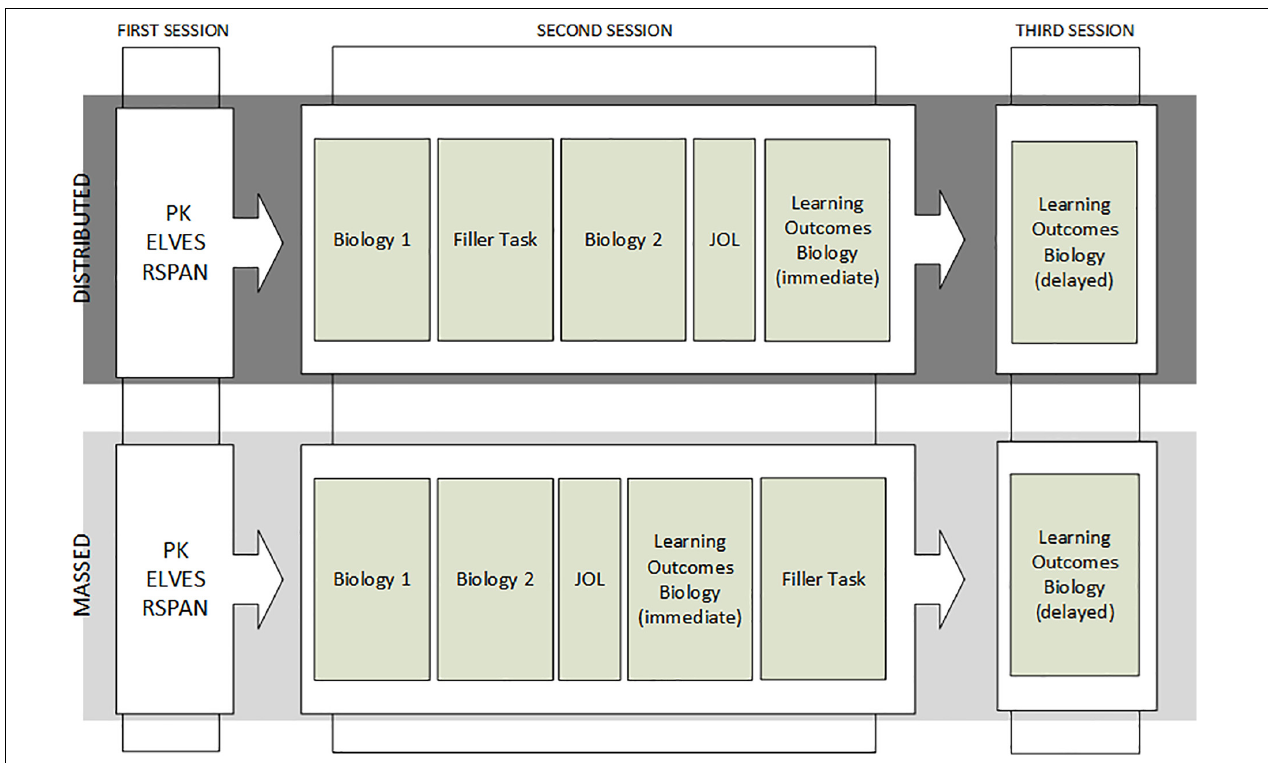
FIGURE 4 | Procedure of Experiment 2 in the Biology Group. An illustration of the procedure of Experiment 2 in the biology group. The example was drawn from the biology group, the procedure was the same for the physics group with the respective texts for physics. PK = Assessment of prior knowledge; ELVES = Assessment of reading ability; RSPAN = Assessment of working memory; Biology 1 = first text biology [first text phyiscs]; JOL = assessment of meta-cognitive judgments of the learning process; Biology 2 = second text biology [second text physics]; and Learning outcomes biology = assessment of learning outcome for biology [assessment of learning outcome for physics]. Learning outcomes were measured immediate after learning (immediate) and 1 week delayed (delayed). TABLE 3 | Mean and standard deviation of dependent variables and learner characteristics in experiment 2.